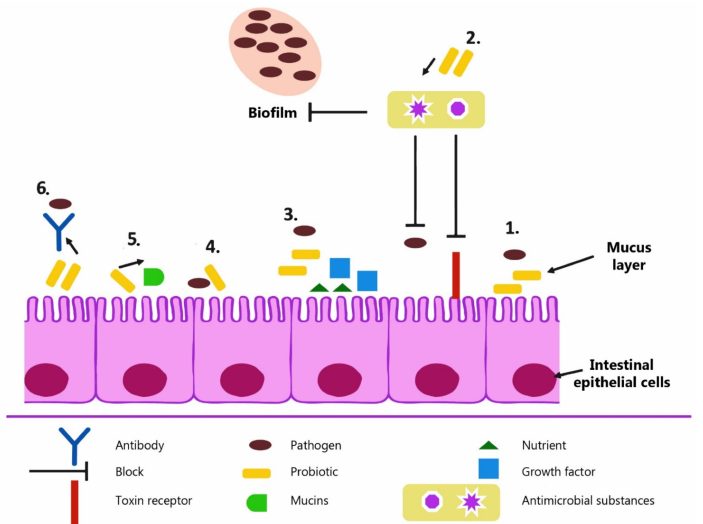
Figure 2. The possible mechanisms of probiotic action. ( 1 ) Competitive exclusion of pathogenic microorganisms. ( 2 ) Production of antimicrobial substances. ( 3 ) Competition for growth factors and nutrients. ( 4 ) Enhancement of adhesion to intestinal mucosa. ( 5 ) Improvement of epithelial barrier function. ( 6 ) Improvement of secretion of IgA